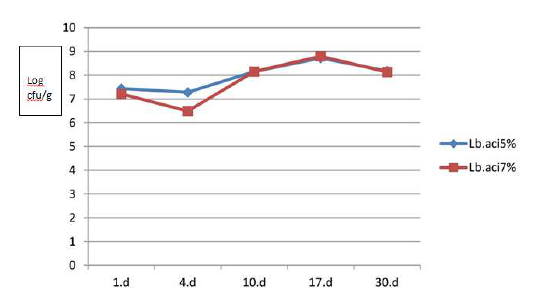
Figure 1. Lb. casei numbers (log CFU/gr).